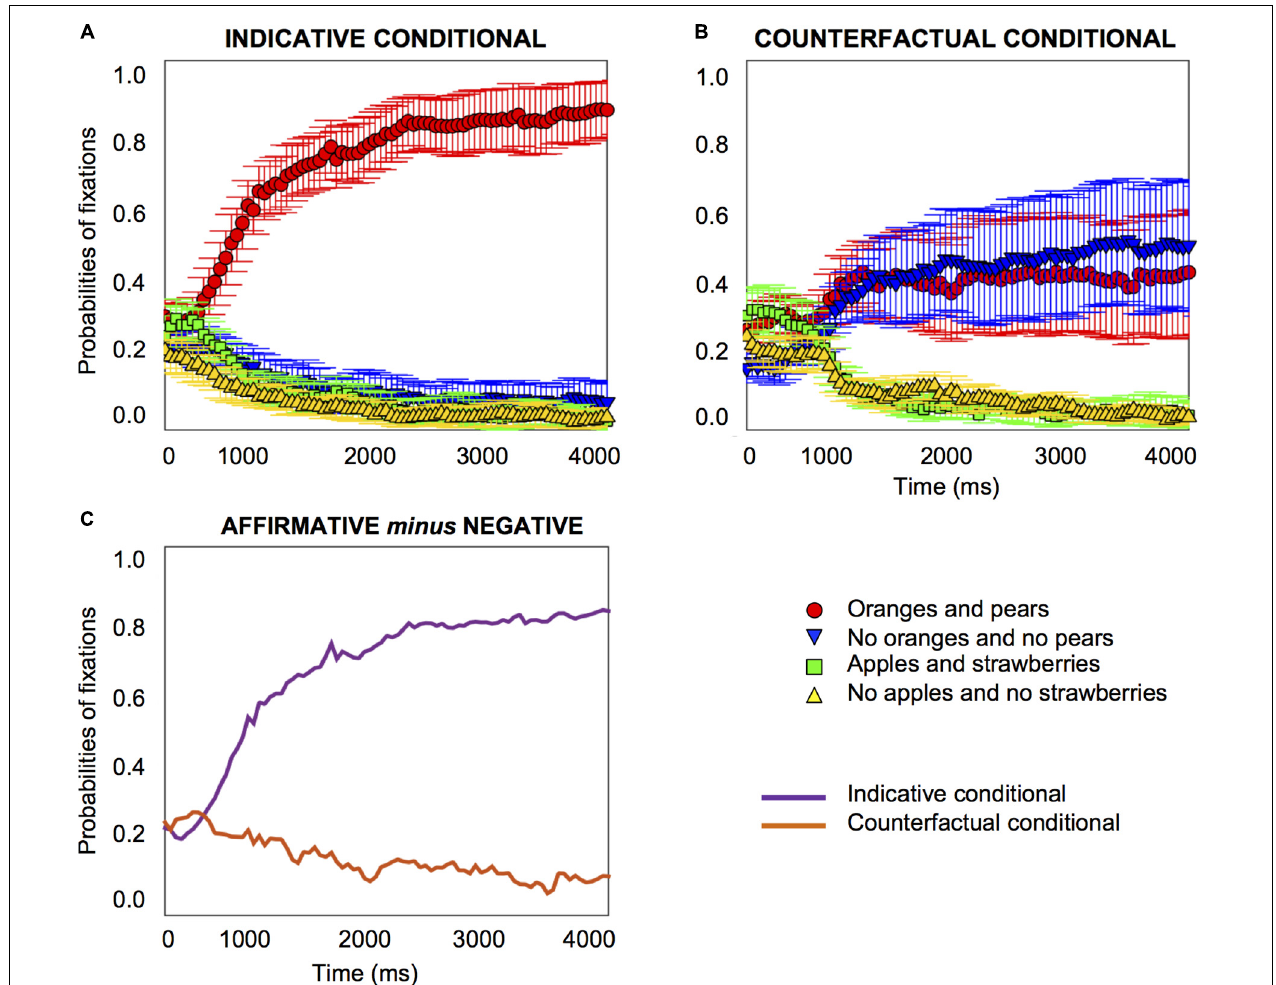
FIGURE 7 | Probabilities of fixations for indicative conditionals, e.g., “if there are oranges, then there are pears” (A) and counterfactual conditionals, e.g., “if there had been oranges, then there would have been pears” (B) in Experiment 3. The differences in the probabilities of fixations (on the affirmative printed words minus the negative printed words) for indicative and counterfactual conditionals emerge at 550 ms , as (C) shows. Error bars are 95% confidence intervals within